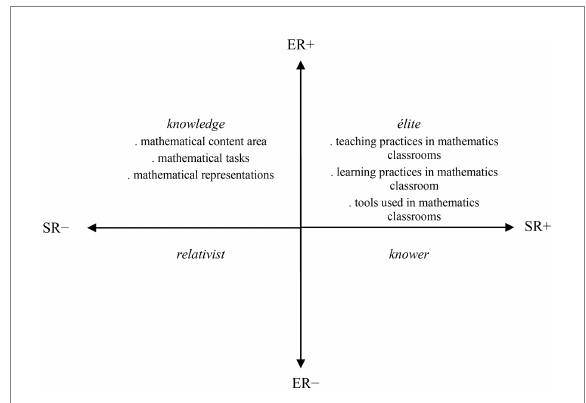
FIGURE 5 Mapping of the DAMC study focuses on the specialization plane.